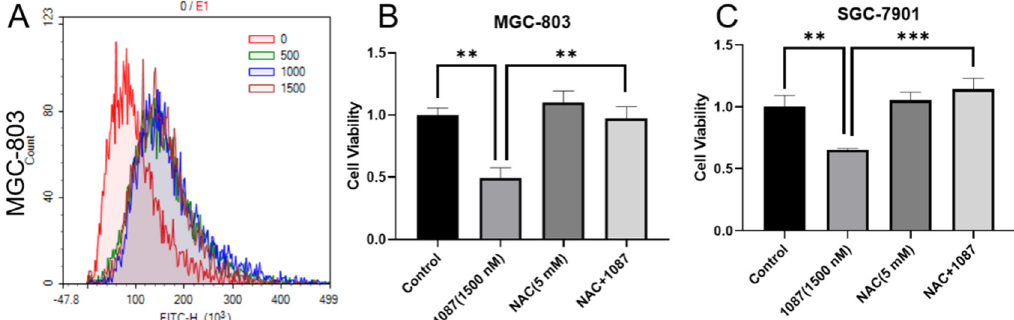
Figure 6. Compound 12e induced ROS generation. ( A ) The levels of ROS in MGC-803 cells, cells were treated indicated concentrations of compound 12e for 48 h, then ROS was labeled by DCFH-DA. ( B , C ) Cell viabilities of two gastric cancer cells, cells were treated with indicated concentrations of compound 12e and/or NAC for 48 h. Date were expressed as mean ± SD, n = 3. Three individual experiments were implemented for per group. ** p < 0.01, *** p < 0.001 vs. control.